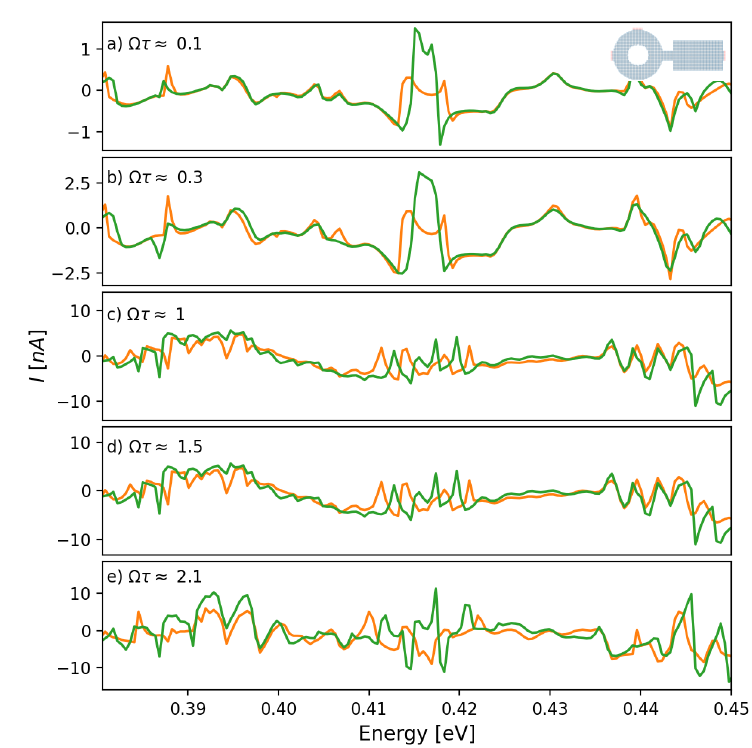
Figure 7: AC charge current in Lead 1, see Fig. 6, generated by the time-dependent and spatially inhomogeneous Rashba SOI. Numerical results based on the Floquet formalism (green) are compared to the current generated by the spin-dependent volt- age and pseudo-magnetic field (orange) in the low- and high-frequency regime. The currents are plotted as a function of the Fermi energy. The analytical results in a) and b) are calculated based on Eq. (52) and in panels c) to e) using Eq. (54). The ( t ) = k L = 1 dynamical Rashba SOI in the right half system is α sin ( Ω t ) with k R so so and the spatially inhomogeneous Rashba SOI in the left half system (the ring) is α ( x ) = k ( L − y ) / L . The size of each system part is L = 50 a . The frequencies used R so are Ω τ ≈ 0.1, 0.3, 1, 1.5 and 2.1 from top to bottom